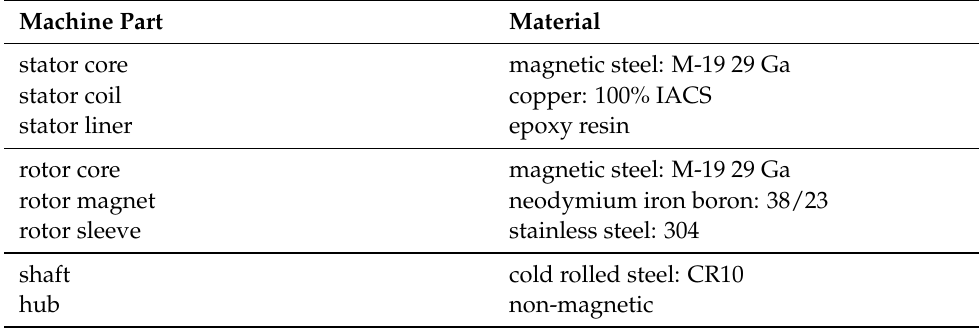
Table A3. Materials used in various machine parts.